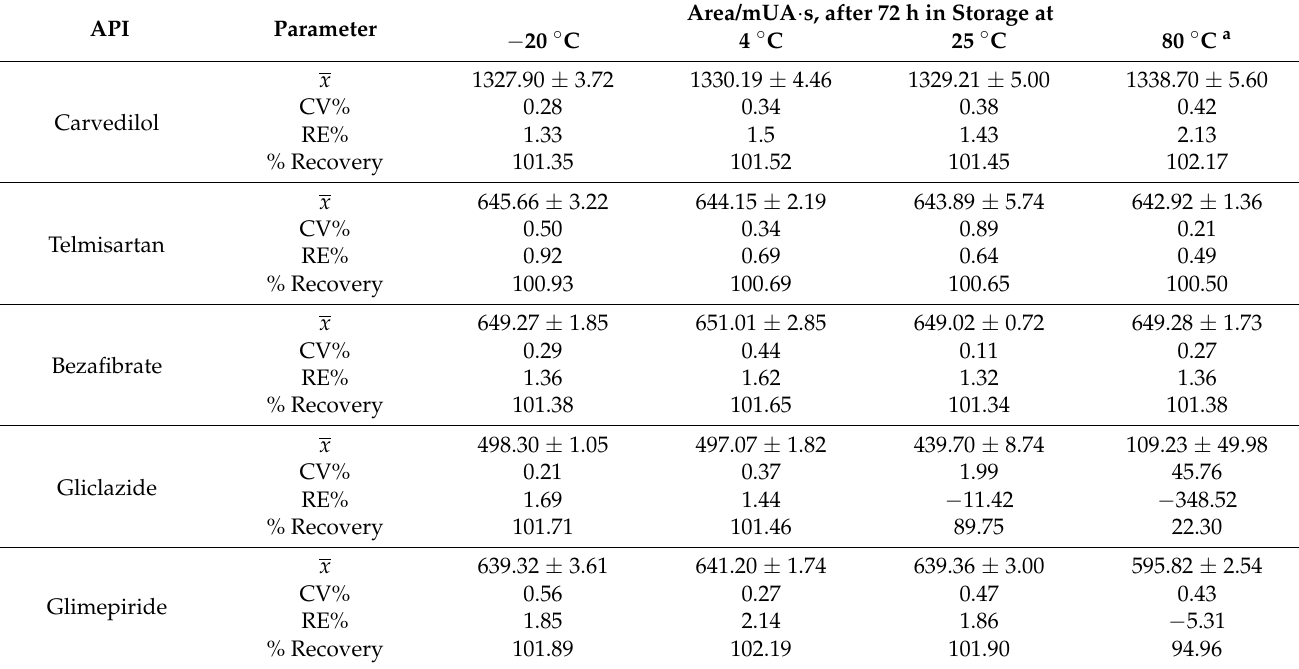
Table 1. Results of stability solutions of active pharmaceutical ingredients (API) after storage.